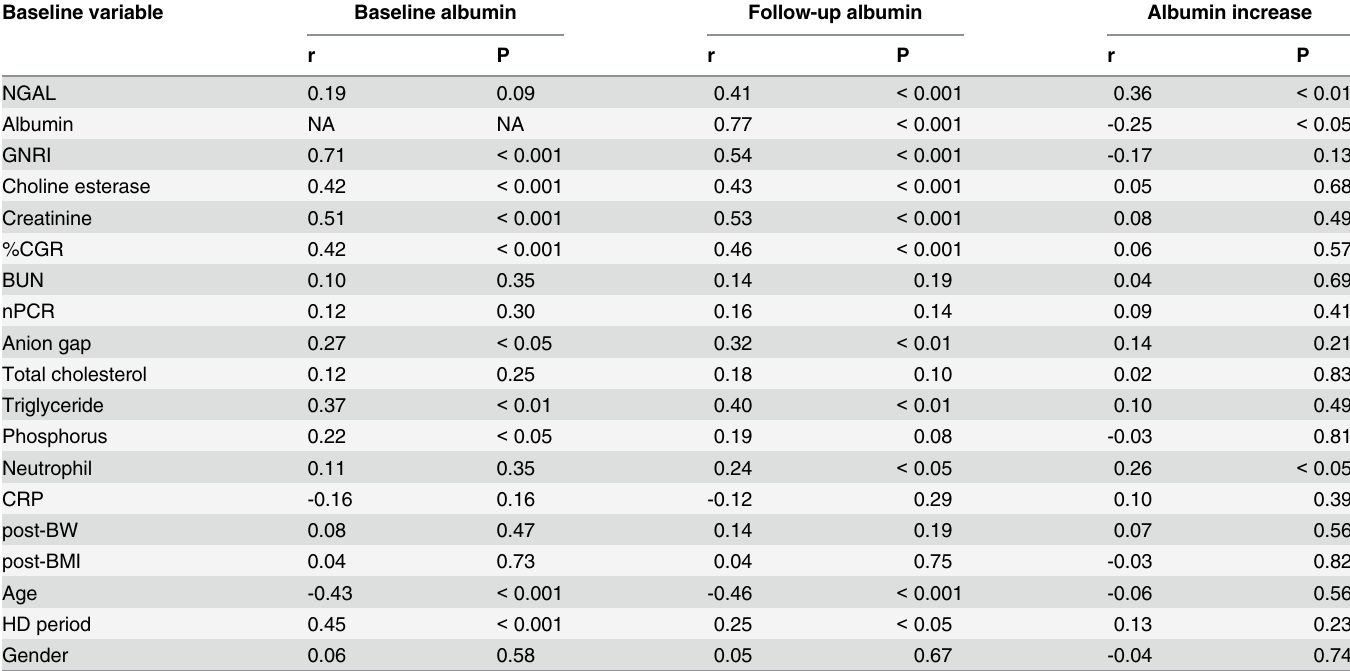
GNRI, geriatric nutritional risk index; post-BW, post-dialysis body weight; post-BMI, post-dialysis body mass index (calculated as the weight in kilograms divided by the square of the height in meters). N =